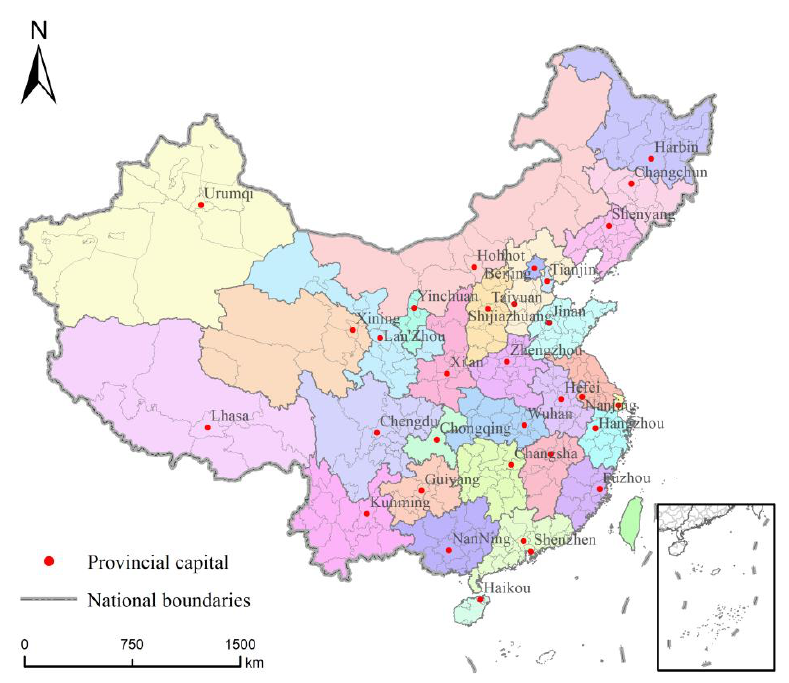
Figure 1. China regional overview map.